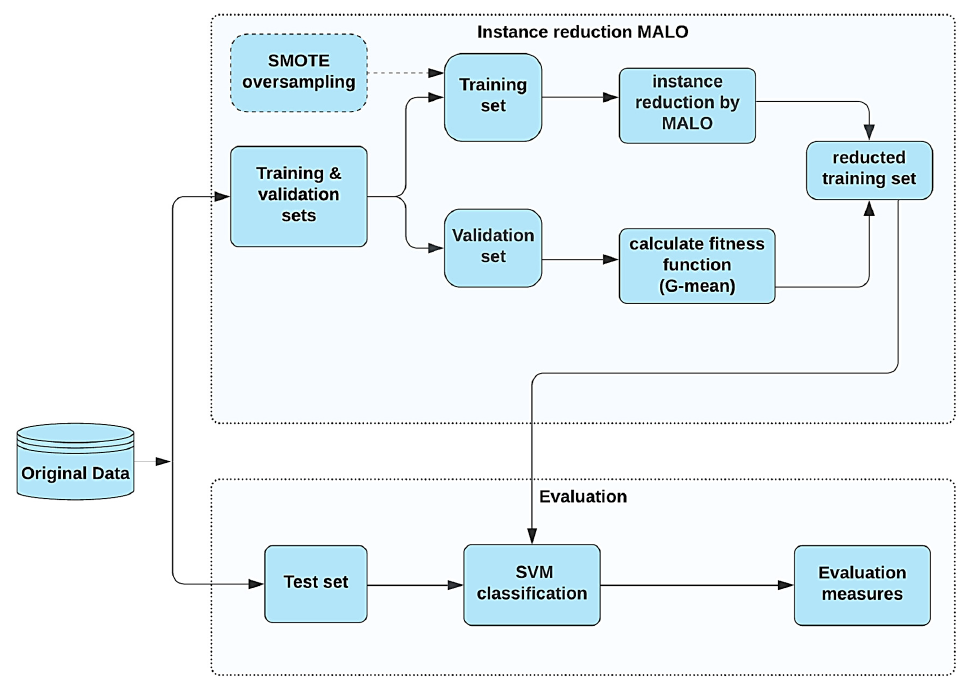
Figure 2. Flow chart of MALO method.